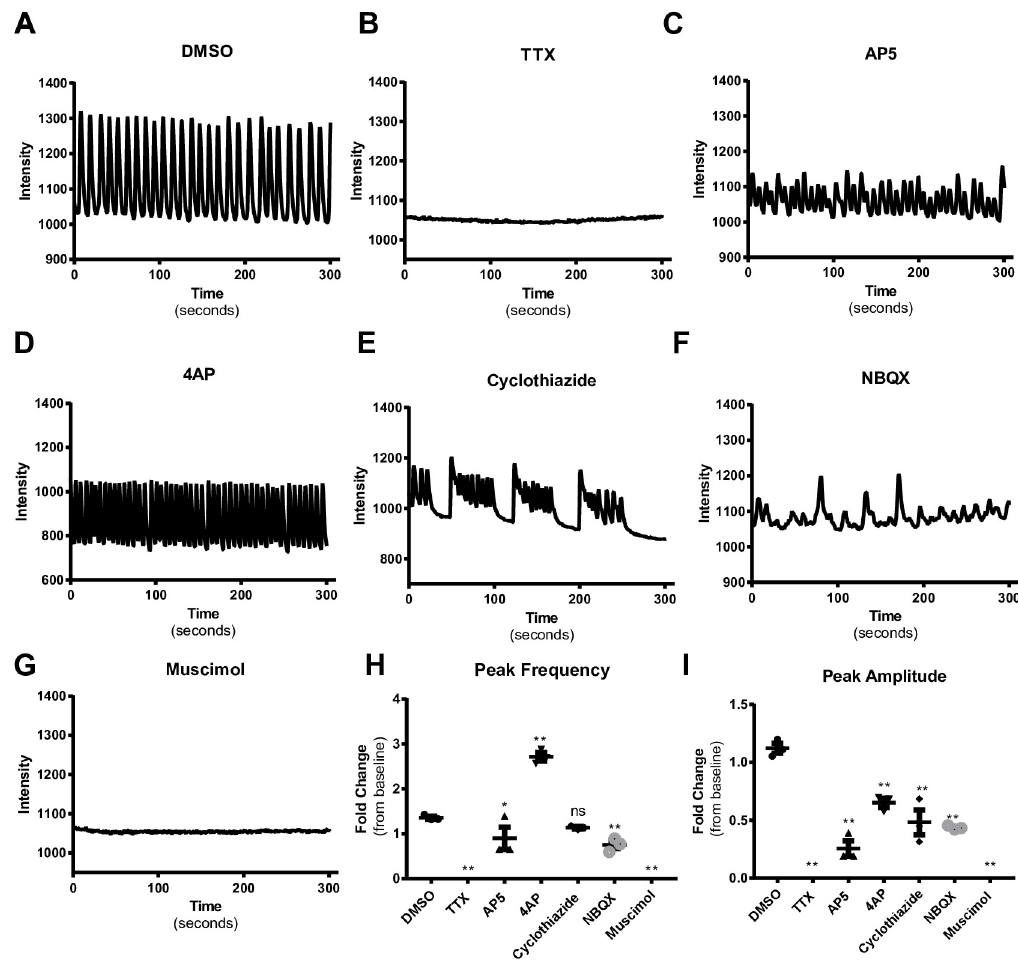
Fig 2. 3D neurospheres respond to known excitatory and inhibitory reference compounds. Representative tracings of calcium dye intensity over time in single wells treated with DMSO or 1 μ M of test compound as indicated in each panel (A-G). H) Quantification of peak frequency from compound treated wells. Each point represents an individual well with three wells per treatment. TTX, AP5 NBQX, and muscimol significantly decreased peak frequency compared with DMSO. 4AP significantly increases peak frequency compared with DMSO. Cyclothiazide and bicuculline did not significantly affect peak frequency compared to DMSO. Error bars represent SEM. I) Quantification of peak amplitude from compound treated wells. TTX, AP5, 4AP, cyclothiazide, NBQX, and muscimol all significantly decrease peak amplitude compared with DMSO. Bicuculline does not significantly affect peak amplitude compared to DMSO. Each point represents an individual well with three wells per treatment. Error bars represent SEM. � indicated P < 0.05, �� indicates P < 0.01, ns indicates P >